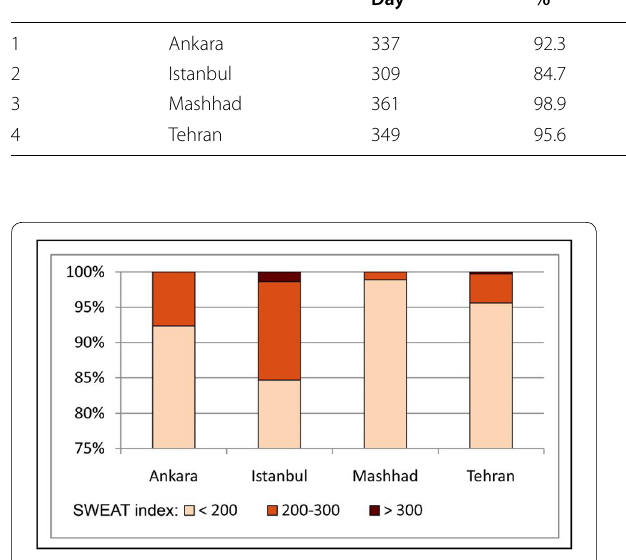
Fig. 5 The percentile contribution the SWEAT daily data to each weather severity class in the study areas (2018)